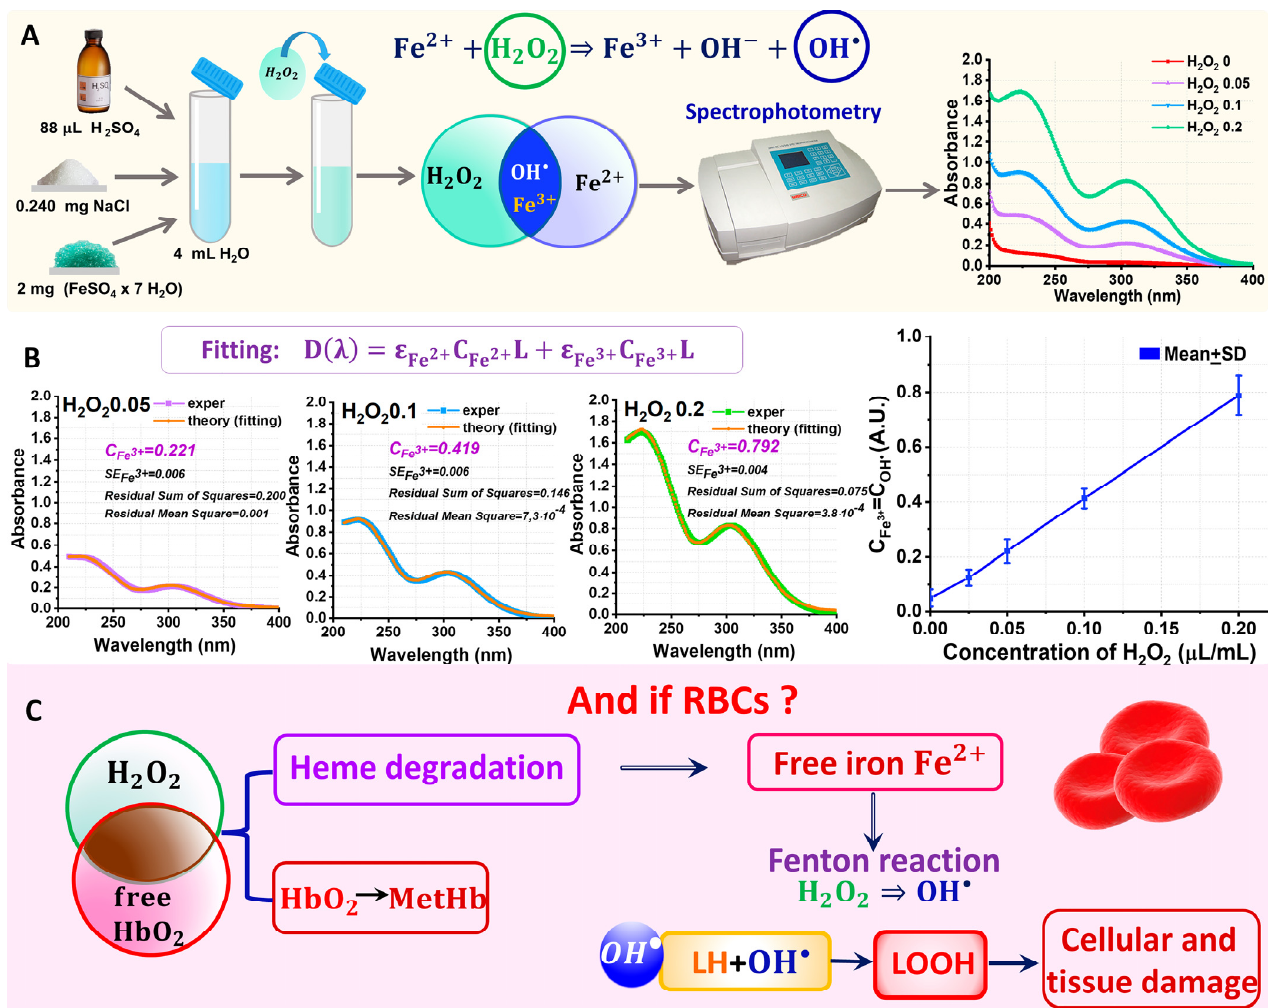
Figure 2. Quantitative study of 𝐻 (cid:2870) 𝑂 (cid:2870) to 𝑂𝐻 • conversion due to the Fenton reaction in in vitro experiment. ( A ) Experimental design with 𝐻 (cid:2870) 𝑂 (cid:2870) and 𝐹𝑒 (cid:2870)(cid:2878) . ( B ) On the left are the fitting results (red lines) of the experimental absorption spectra (green, cyan, and violet symbols) for the samples 𝐻 (cid:2870) 𝑂 (cid:2870) 0.2 , 𝐻 (cid:2870) 𝑂 (cid:2870) 0.4 , and 𝐻 (cid:2870) 𝑂 (cid:2870) 0.8 . The calculated concentrations 𝐶 (cid:3007)(cid:3032) (cid:3119)(cid:3126) , the SE of fitting, and residuals are indicated on each graph. The dependence 𝐶 (cid:3007)(cid:3032) (cid:3119)(cid:3126) (𝐶 (cid:3009) (cid:3118) (cid:3016) (cid:3118) ) , which corresponds to the dependence 𝐶 (cid:3016)(cid:3009) (𝐶 (cid:3009) (cid:3118) (cid:3016) (cid:3118) ) , is shown on the right; the data are presented as mean ± SD. ( C ) Consequences of the interaction of 𝐻 (cid:2870) 𝑂 (cid:2870) molecules and RBCs include 𝑀𝑒𝑡𝐻𝑏 formation, heme degradation production of free 𝐹𝑒 (cid:2870)(cid:2878) , generation of 𝑂𝐻 • due to the Fenton reaction, initiation of a chain LPO reaction in membranes, and damage to cells and tissues.